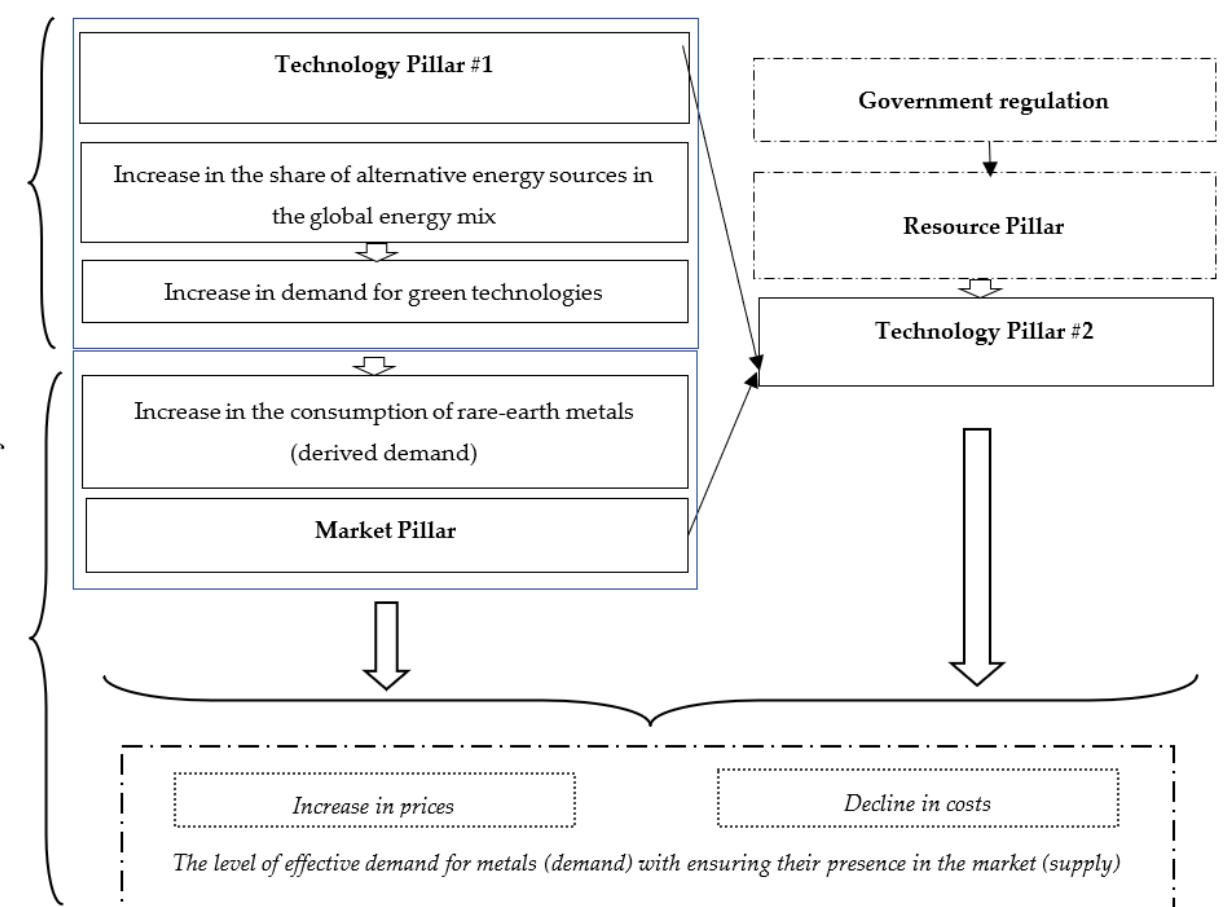
Figure 4. Conceptual framework for the development of the rare-earth metal industry in the context of global energy transition trends.